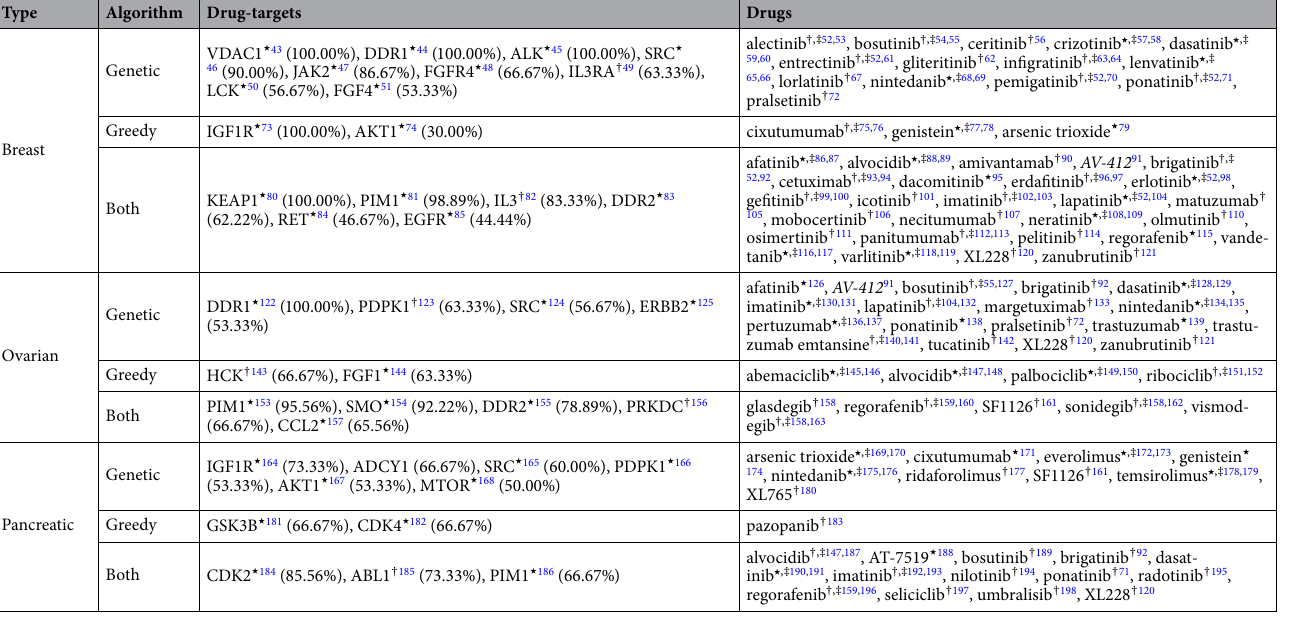
Table 2. The intersection and the algorithm-specific predicted drug-targets and corresponding drugs. Only the drug-targets that have been identified in at least half of the iterations for at least one algorithm have been considered. In brackets: percentage of individual iterations in which the drug-target was identified for the ⋆ corresponding cancer type; with a : proteins known to be of significance in the corresponding cancer type and drugs investigated for or used in the treatment of the corresponding cancer type, with a † : proteins known to be of significance in other or unspecified cancer types and drugs investigated for or used in the treatment of other or unspecified cancer types, with a ‡ : drugs investigated for the treatment of the corresponding cancer type within active or completed clinical trials.